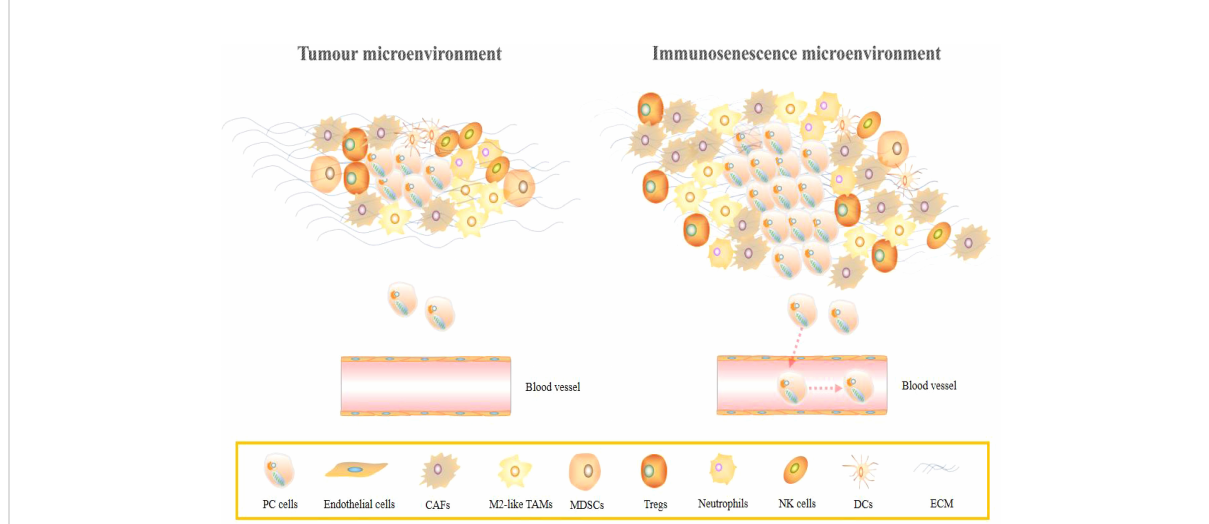
FIGURE 4 Schematic presentation of immune aging in PC. In a normal PC microenvironment, due to the presence of anti-tumour immune cells such as NK cells, the proliferation, invasion and vascular invasion of cancer cells are inhibited. However, in the immunosenescence microenvironment, the tumour suppressive abilities of immune cells are weakened, and rapid proliferation of cancer cells simultaneously induces massive in fi ltration of cancer-promoting immune cells, including Tregs as well as TAMs, and promotes cancer cell vascular invasion and distant